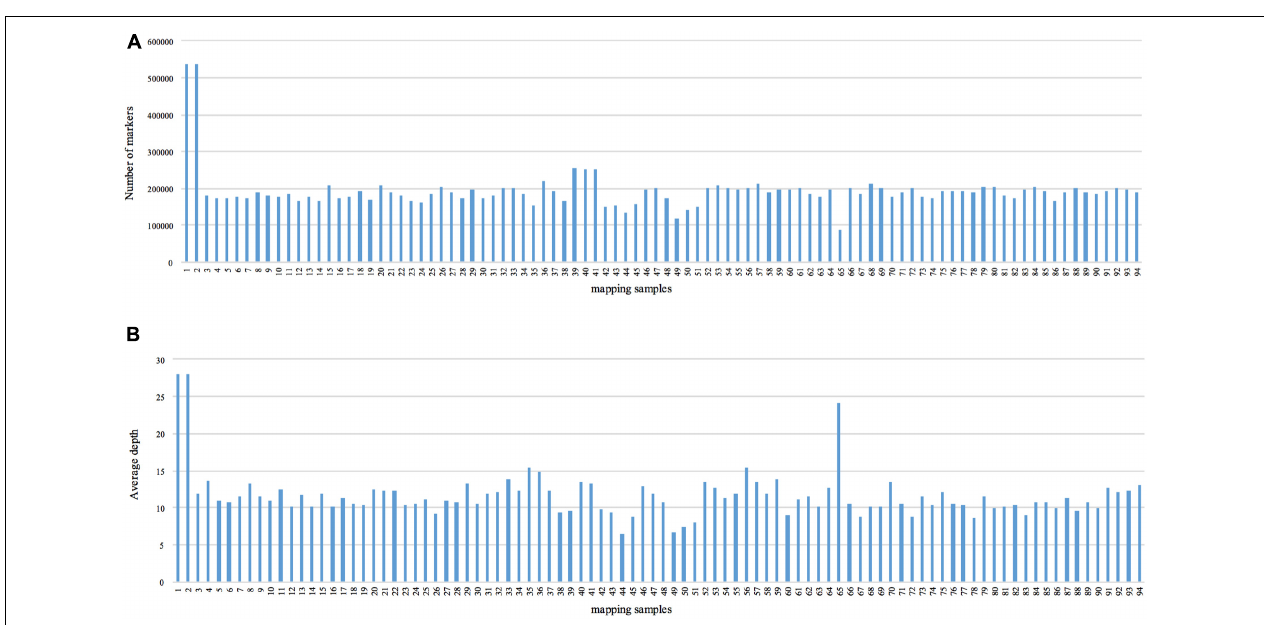
Frontiers in Plant Science |